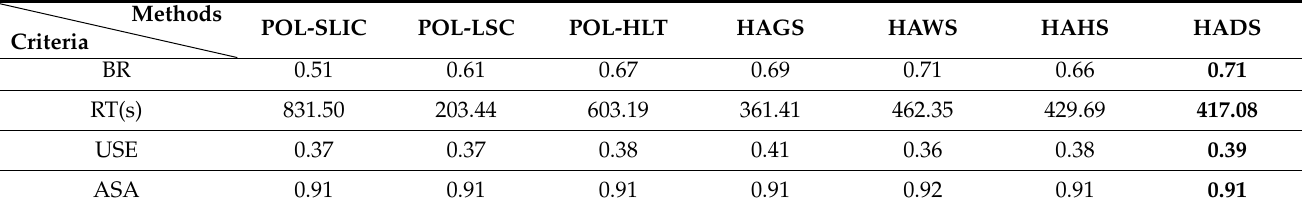
Figure 16. Enlarged results for region B of data set 1. ( a ) POL-SLIC. ( b ) POL-LSC. ( c ) POL-HLT. ( d ) HAGS. ( e ) HAWS. ( f ) HAHS. ( g ) The proposed HADS. ( h ) Pauli-RGB image. Table 4. Four evaluation criteria for 7 methods based on data set